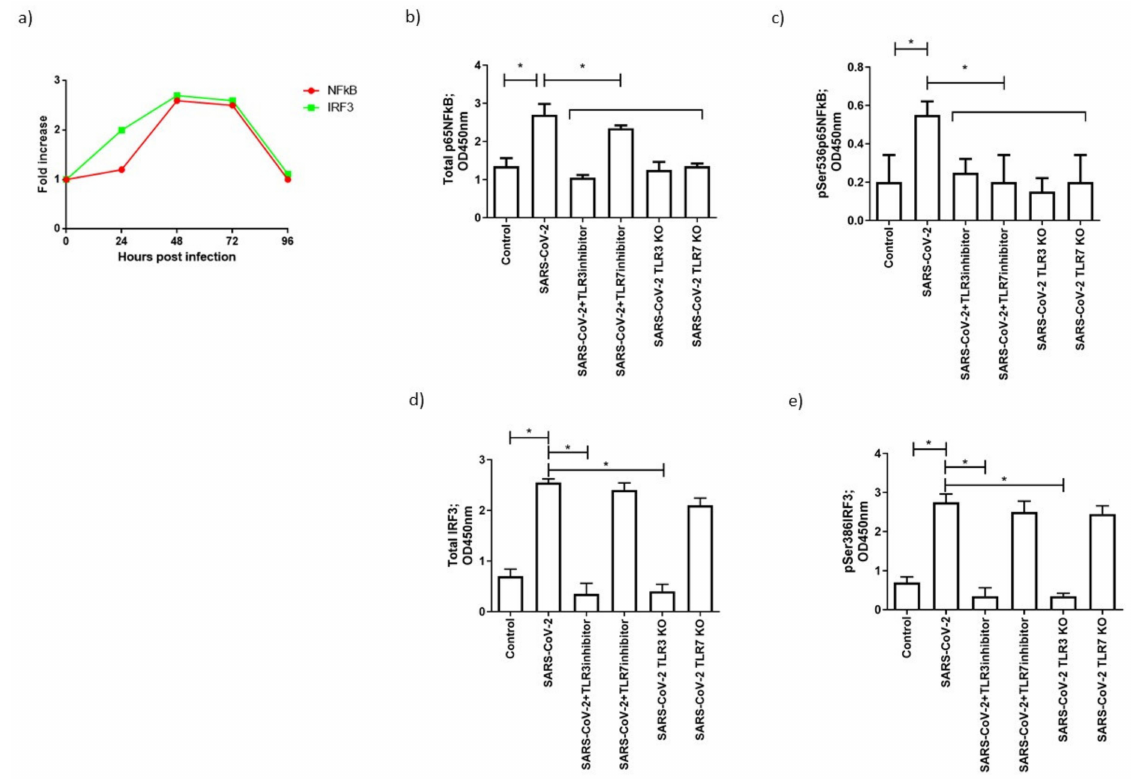
Figure 4. ( a ) Levels of expression, quantified as fold increase in comparison to uninfected cells, of NF- κ B and IRF3, are reported and are representative of three independent experiments. Levels of ( b ) total and ( c ) phosphorylated NF- κ B and of ( d ) total and ( e ) phosphorylated IRF3 in Calu-3/MRC-5 multicellular spheroids infected with SARS-CoV-2 and analyzed 48 h post-infection, with or without inhibitor (inhibitor) or silencing (KO) treatment. Data correspond to the mean +/ − standard deviation. * p value < 0.05, calculated with Student’s t